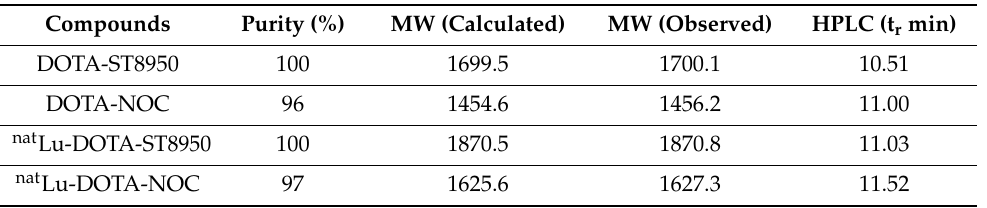
Table 1. Analytical data of the DOTA-conjugates and of their corresponding nat Lu complexes. Compounds Purity (%) MW (Calculated) MW (Observed) HPLC (t r min) DOTA-ST8950 100 1699.5 1700.1